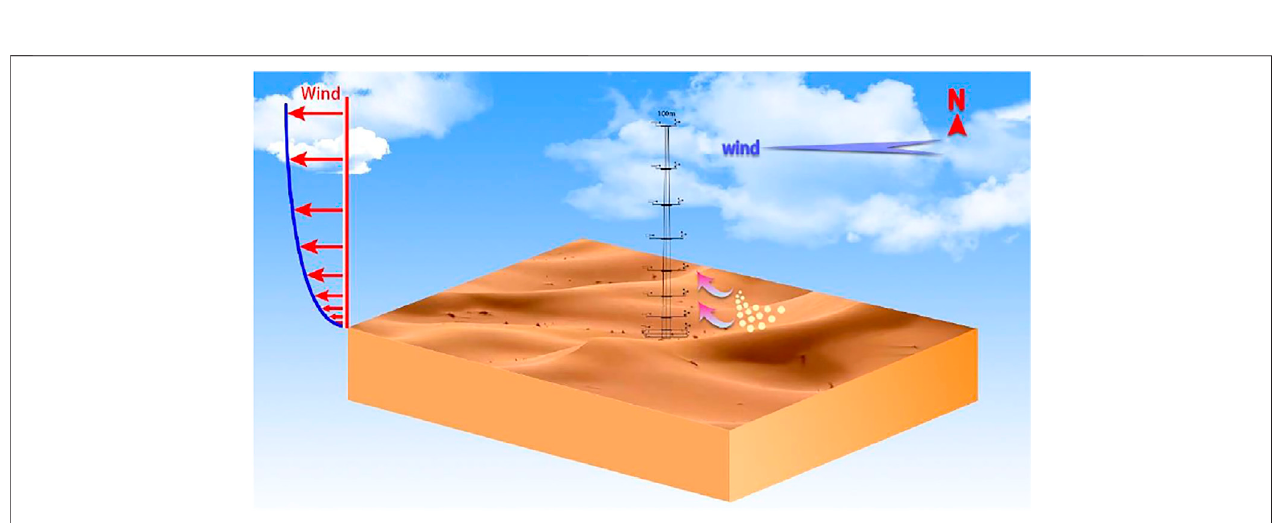
FIGURE 11 | Conceptual diagram of dust transport from multiple sand sources during a dust storm in XT.